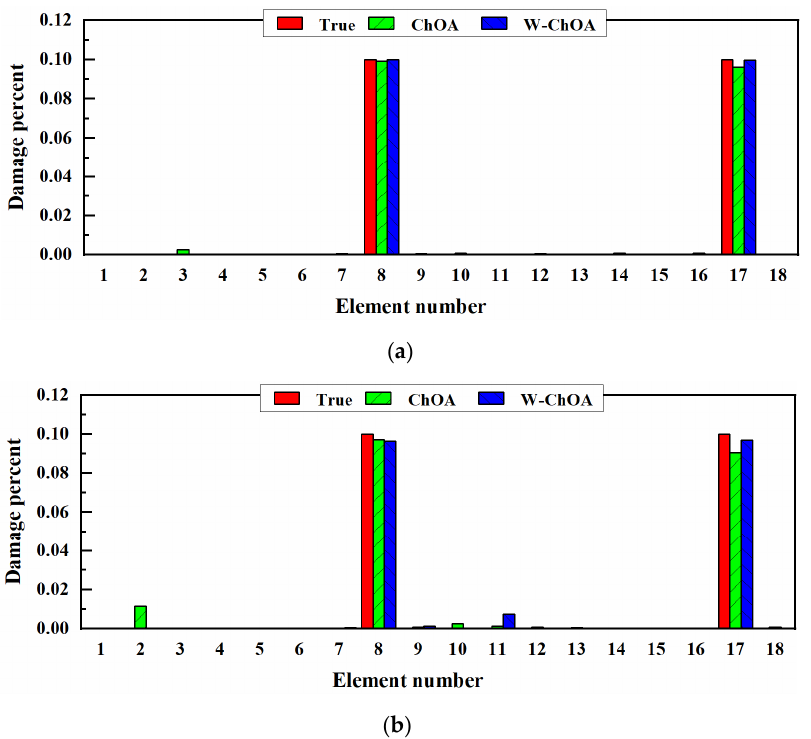
Figure 6. Double damage detection results of two-story rigid frame by two chimp-based optimization algorithms. ( a ) 5% noise level. ( b ) 10% noise level.